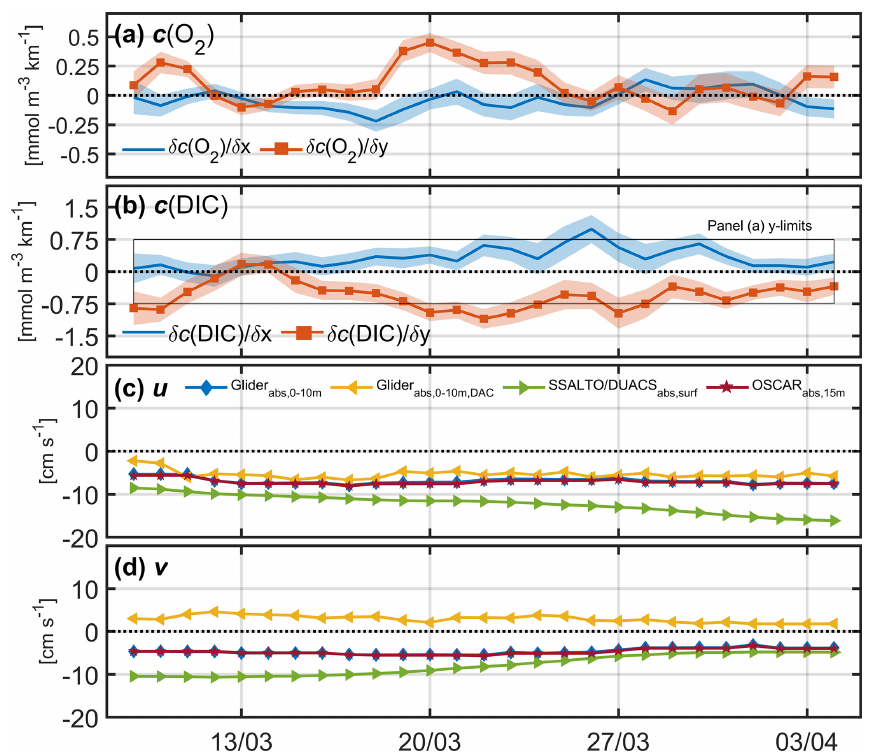
Figure 8. Zonal and meridional mean horizontal concentration gradients for (a) c( O 2 ) and (b) c( DIC ) estimated using robust plane fits. The black box in panel (b) highlights the y limits for panel (a) for reference. (c) Absolute mean u velocity and (d) v velocity using glider measurements in the top 10m referenced to OSCAR velocities (blue), and referenced to dive-averaged currents (DACs, yellow), absolute surface mean currents from satellite products SSALTO/DUACS (green) and OSCAR